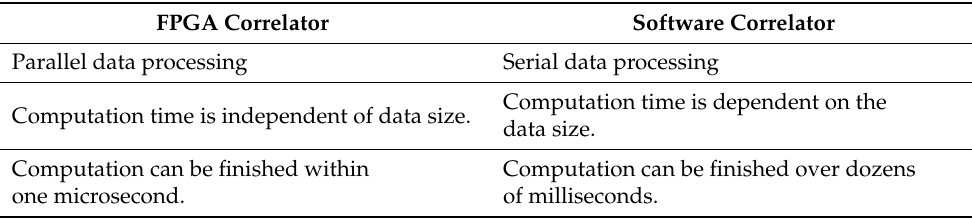
Table 5. Comparison of the FPGA correlator with the software correlator. FPGA Correlator Parallel data